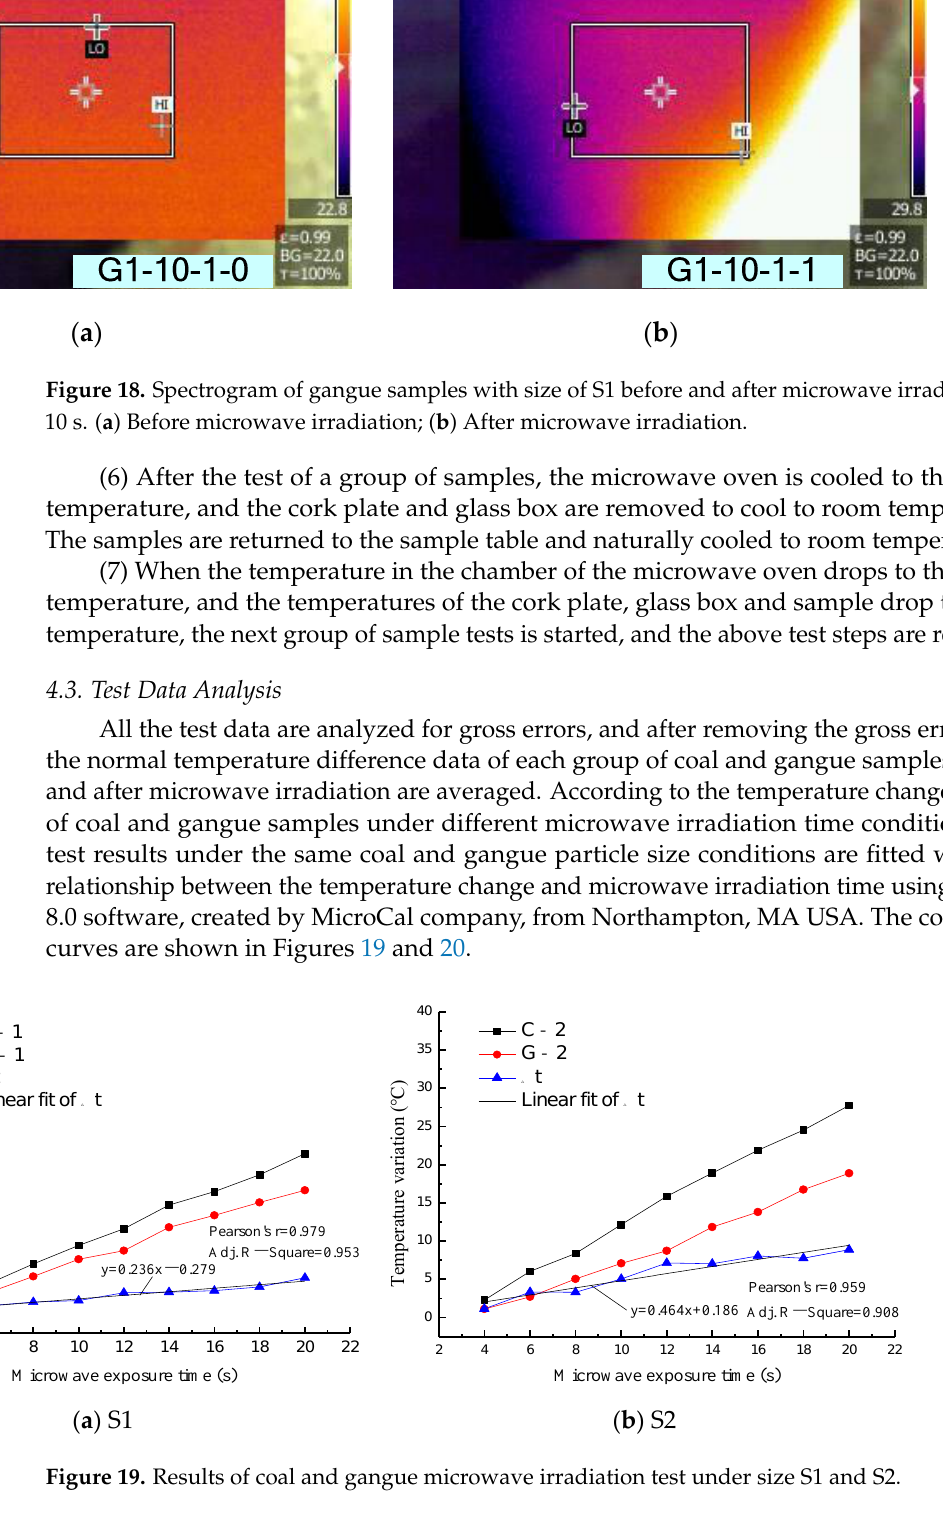
Figure 19. Results of coal and gangue microwave irradiation test under size S1 and S2.